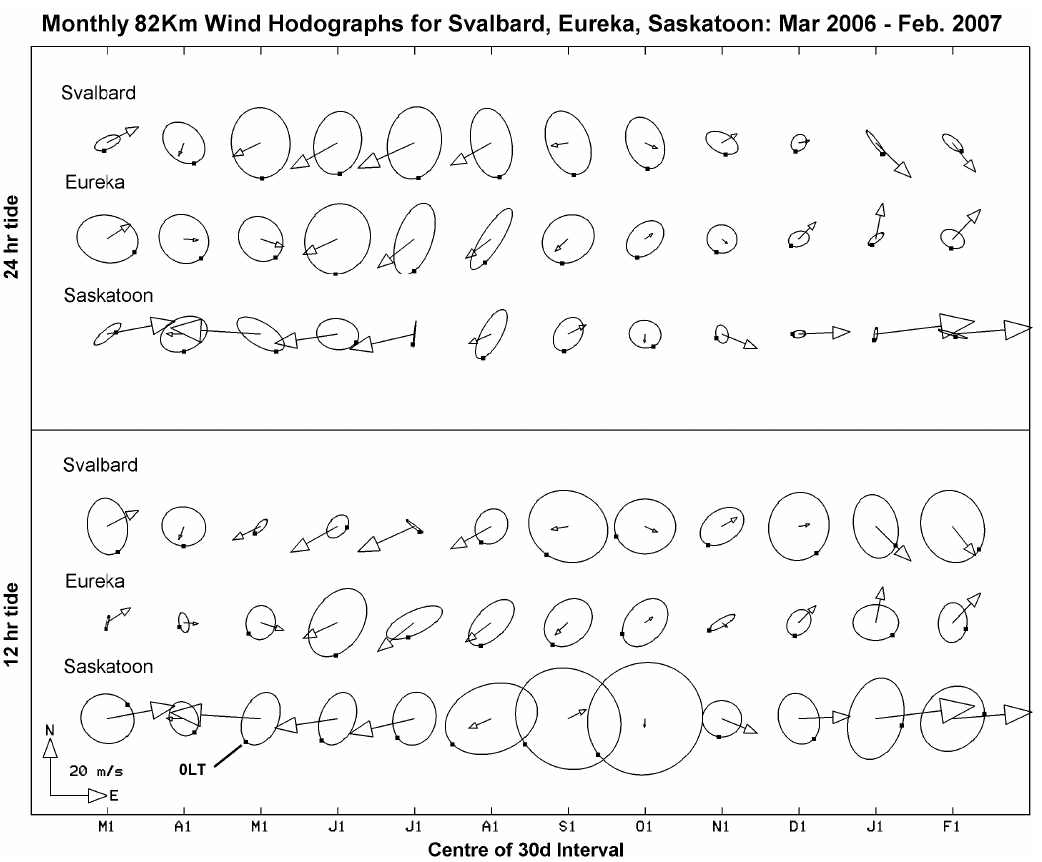
Fig. 6. Hodographs for the 24 and 12h tidal components at 82km from the Eureka and Svalbard radars along with those for the high mid- latitude MFR at Saskatoon (52N). The arrows show the monthly mean winds, and the small black squares on the hodographs indicates the position of the tidal wind vector at